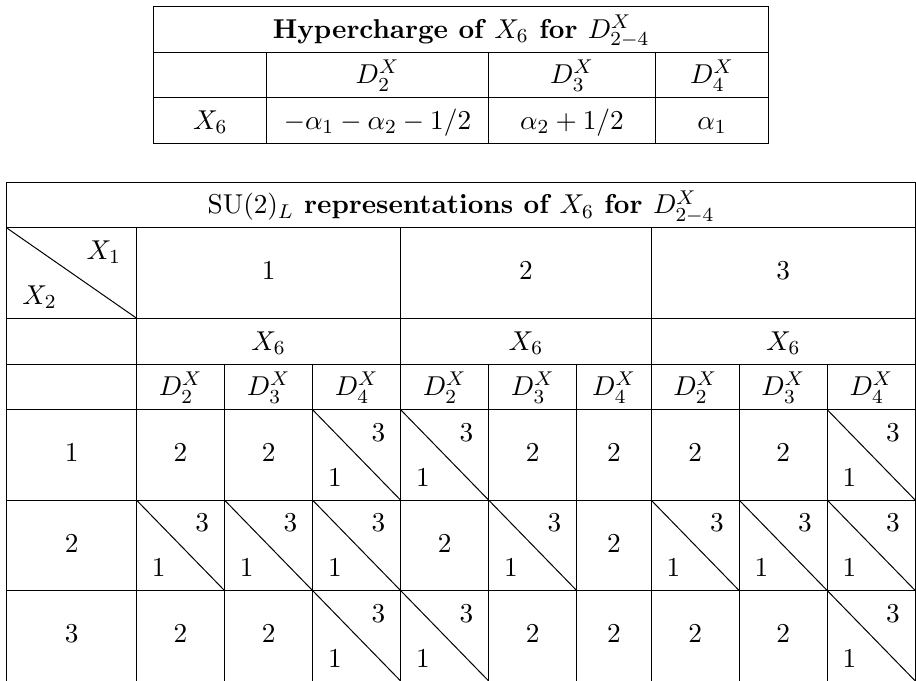
, D X and D X 2 3 4